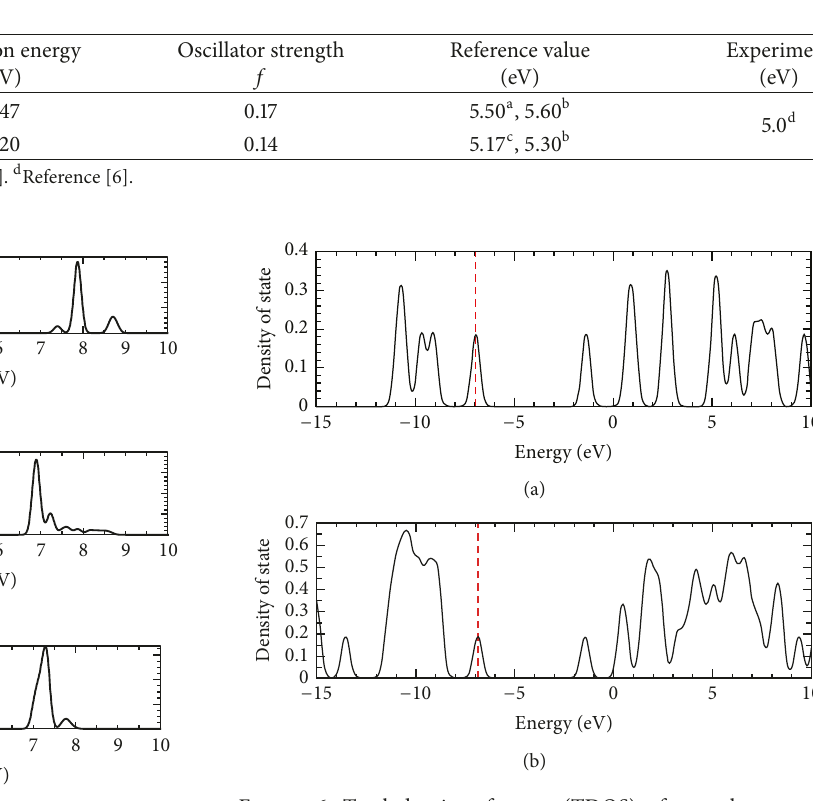
Figure 6: Total density of states (TDOS) of two clusters with ODC(II) defect. (a) SiO 2 H 2 ; (b) Si 3 O 8 H 6 . The red vertical dashed lines align to highlight highest occupied molecular orbital (HOMO)